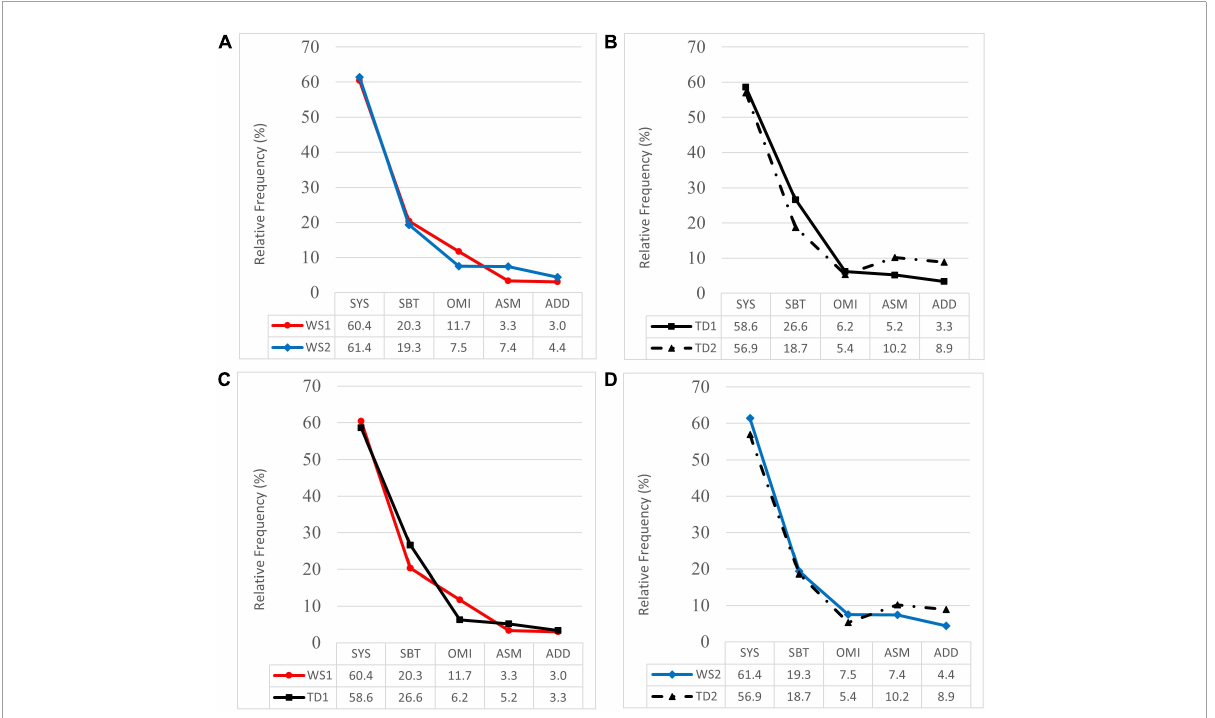
FIGURE1 Profiles of relative frequency of processes by classes (SYS, syllable structure; SBT, substitution; OMI, omission; ASM, assimilation; ADD, addition) for WS groups and TD groups. (A) Profiles of WS1 and WS2 groups. (B) Profiles of TD1 and TD2 groups. (C) Profiles of WS1 and TD1groups. (D) Profiles of WS2 and TD2